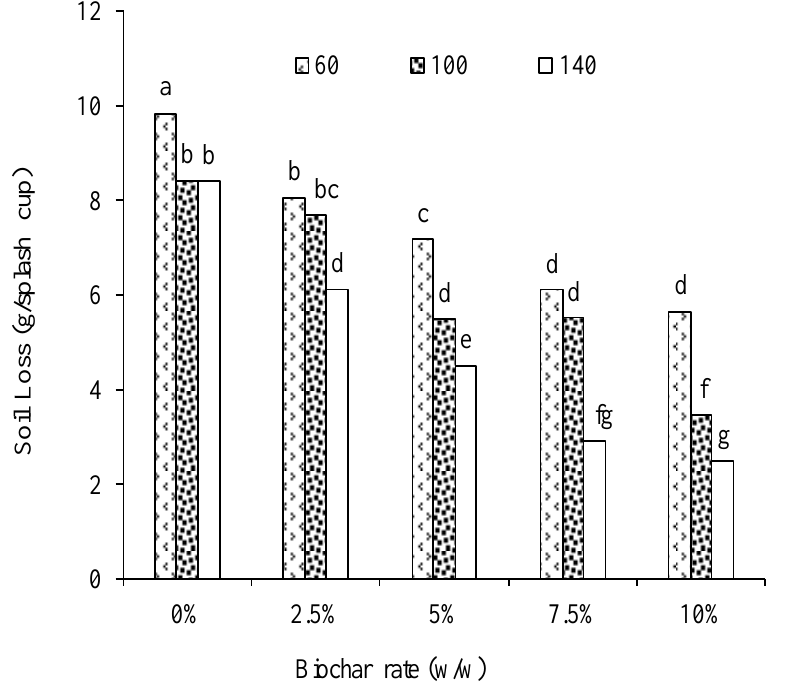
Figure 8. Changes in soil loss during incubation of a Hutton soil amended with different biochar rates. Different lowercase letters indicate significant differences at p ≤ 0.001.